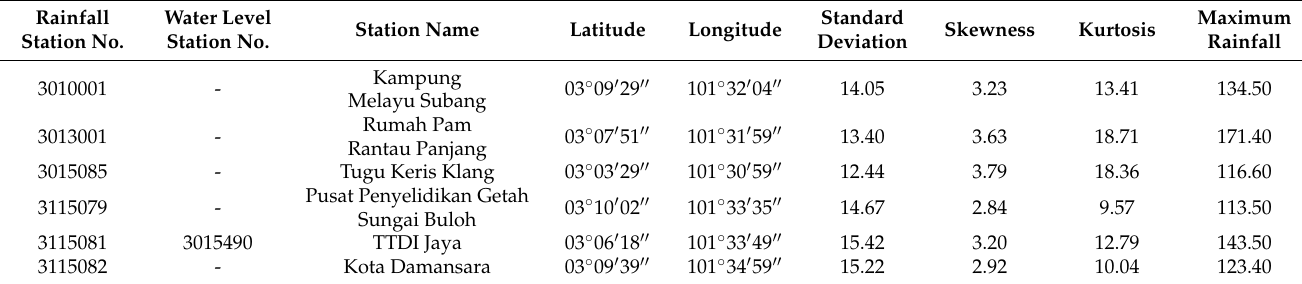
Table 2. Summary statistics of daily recorded rainfall series in Damansara catchment (2009–2019). Rainfall Water Level Station No. Station